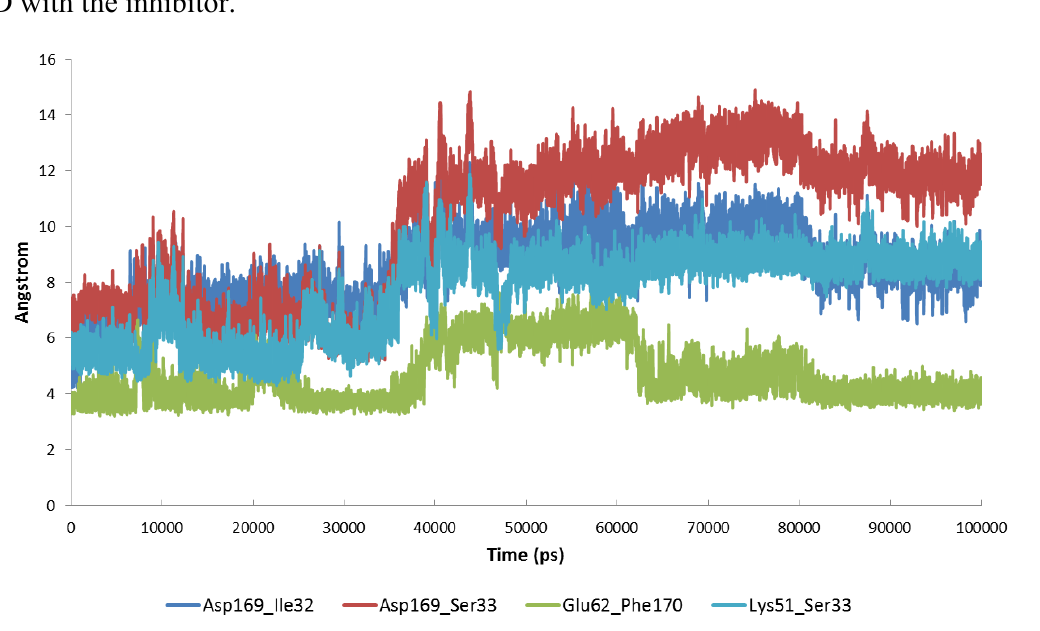
Figure 9. Atom distances between central amino acids at the binding site during 100 ns MD with the